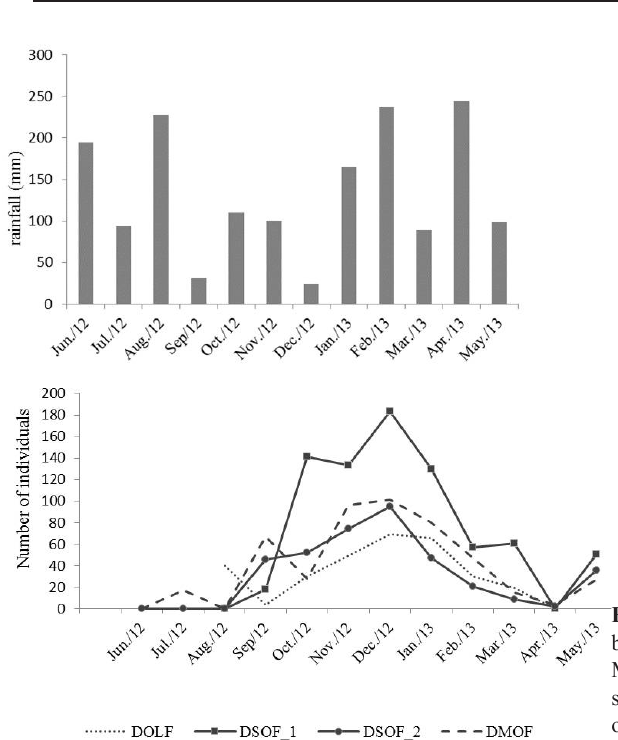
Fig 4. Rainfall (a) and monthly fluctuations in the abundance of Euglossini bees (b) in four areas in the Brazilian Atlantic forest, from June 2012 to May 2013. DLOF: dense lowland ombrophilous forest), DSOF_1: dense submontane ombrophilous forest, area 1, DSOF_2: dense submontane ombrophilous forest, area 2, DMOF: dense montane ombrophilous